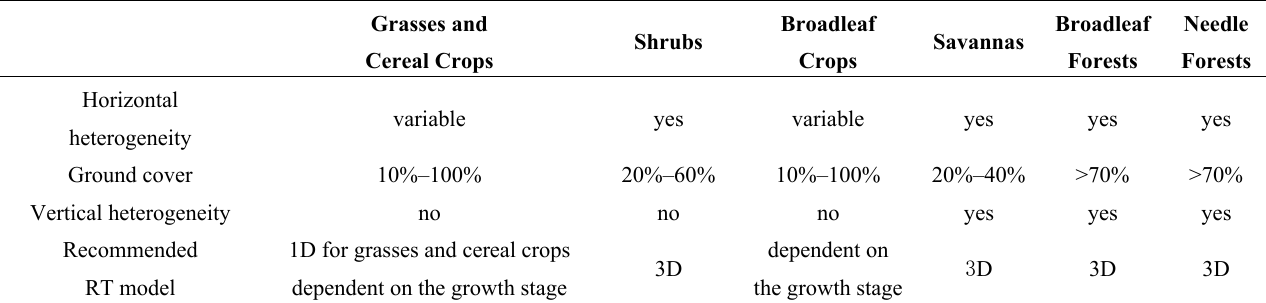
recommended RT models suitable for Leaf Area Index (LAI) retrieval.